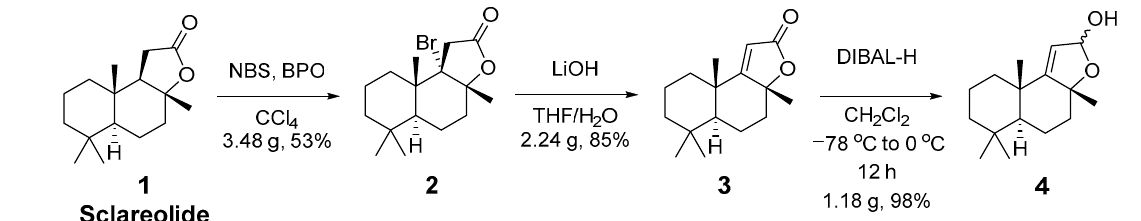
Figure 1. Design of sclareolide-indole conjugates and analogues